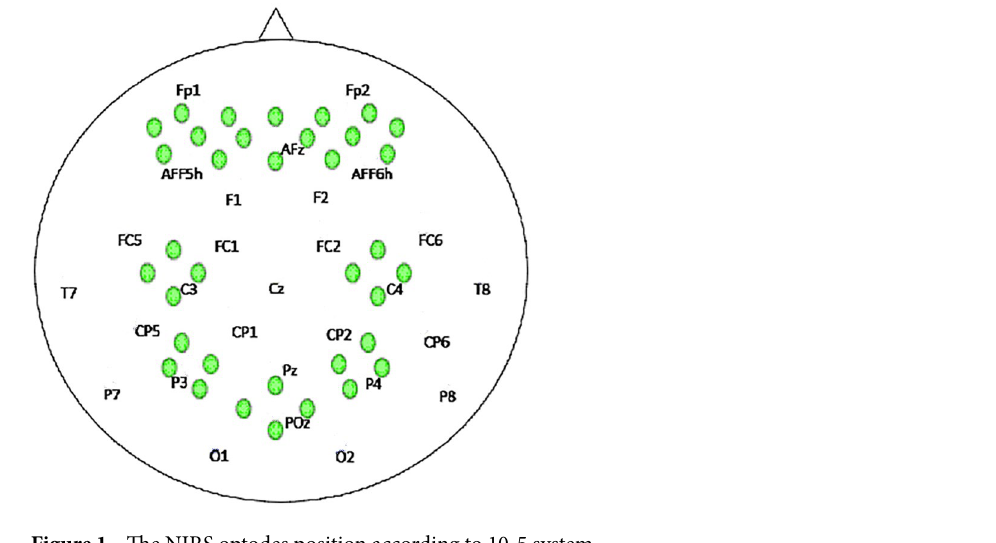
Figure 1. The NIRS optodes position according to 10-5